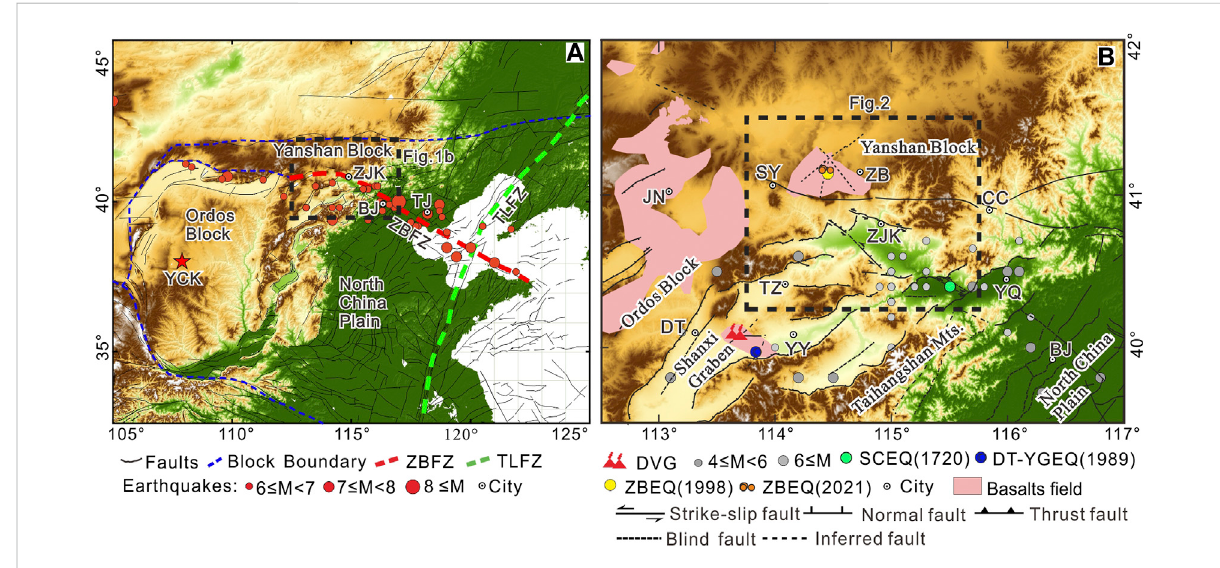
FIGURE 1 (A) Locationofthestudyregion. (B) Topographic mapoftheWesternsegmentofZhangbofaultzone.Faultsaremodi fi edfromZhou(2011)and Luo et al. (2021); Moderately and strong earthquakes (BC 231-AD 2018) are from Liu et al. (2017) and Hu et al. (2021); Abbreviations are: ZBFZ, Zhangbo fault zone; TLFZ, Tanlu fault zone; DVG, Datong Volcanoes group; JN, Jining; SY, Shangyi; ZB, Zhangbei; CC, Chicheng; ZJK, Zhangjiakou; TZ, Tianzhen; YQ, Yanqing; DT, Datong; YY, Yangyuan; BJ, Beijing; YCK, Remote reference station; LPF, Langshan Piedmont fault; LHF, Linhe fault; DKF, Dengkou fault; QS, Qingshan; HJHQ, Hangjinhouqi; LH, Linhe; DK, Dengkou; WH, Wuhai; WLTHQ, Wulatehouqi; WY, Wuyuan; WLTQQ, Wulateqianqi; WLTZQ, Wulatezhongqi; HJQ,